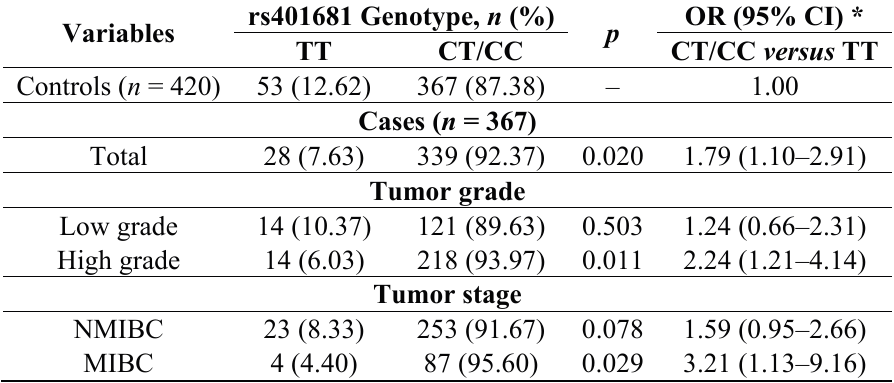
Table 5. Stratification analysis of association between rs401681 polymorphism and bladder